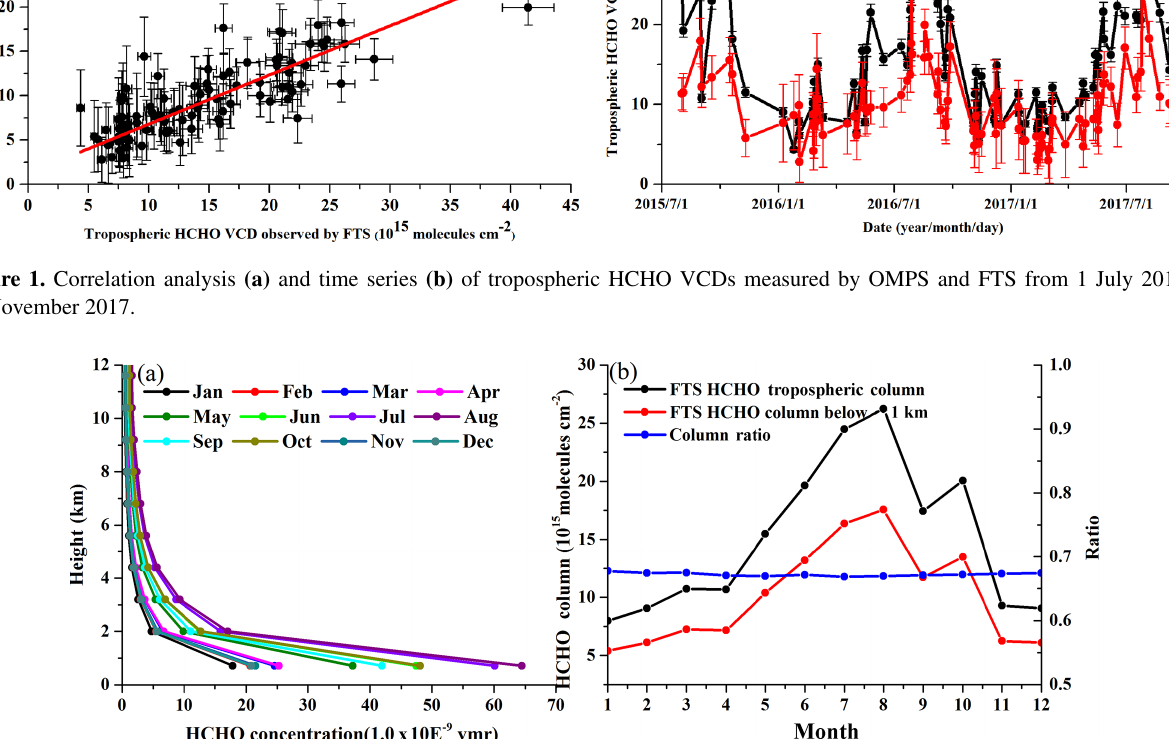
Figure 2. (a) The monthly averaged HCHO vertical profiles in the troposphere measured by FTS. (b) The monthly averaged tropospheric HCHO column (black line), the HCHO column below 1km (red line) measured by FTS, and the ratio of the HCHO column below 1km in the tropospheric HCHO column (blue